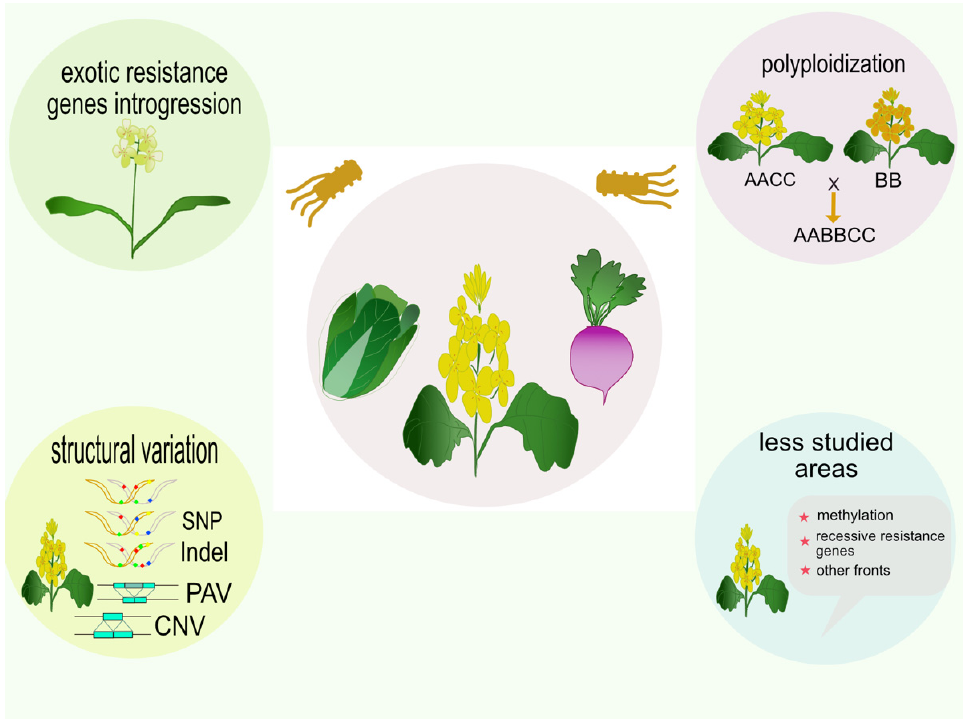
Figure 2. Major forces related to study of R gene evolution in Brassica.